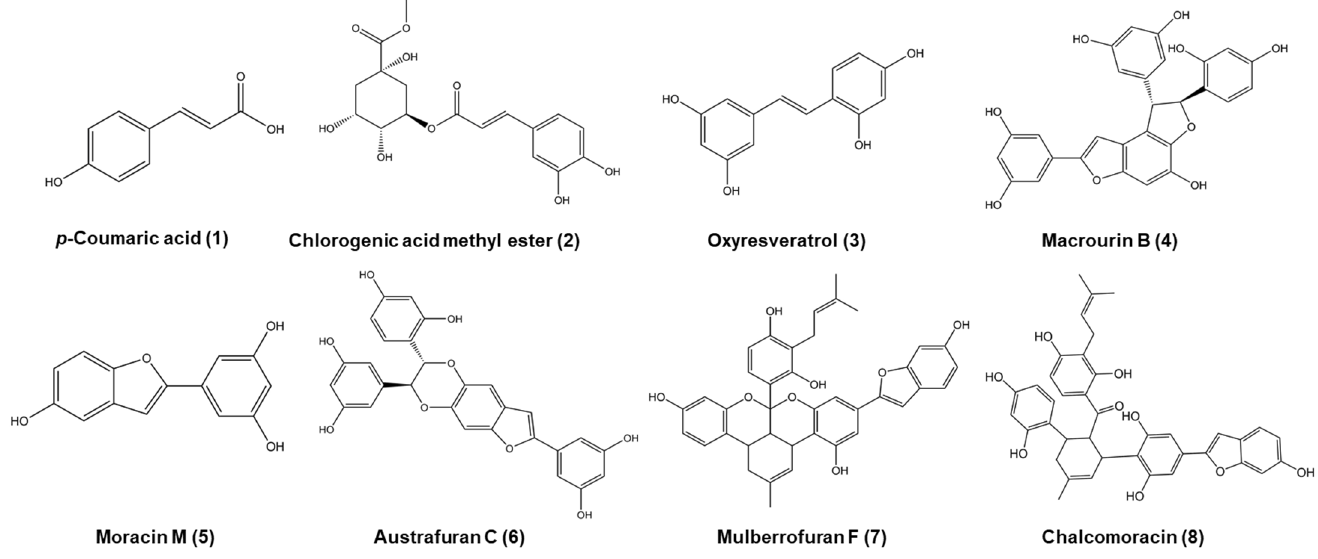
Figure 1. The structures of isolated compounds from Morus bombycis leaves.